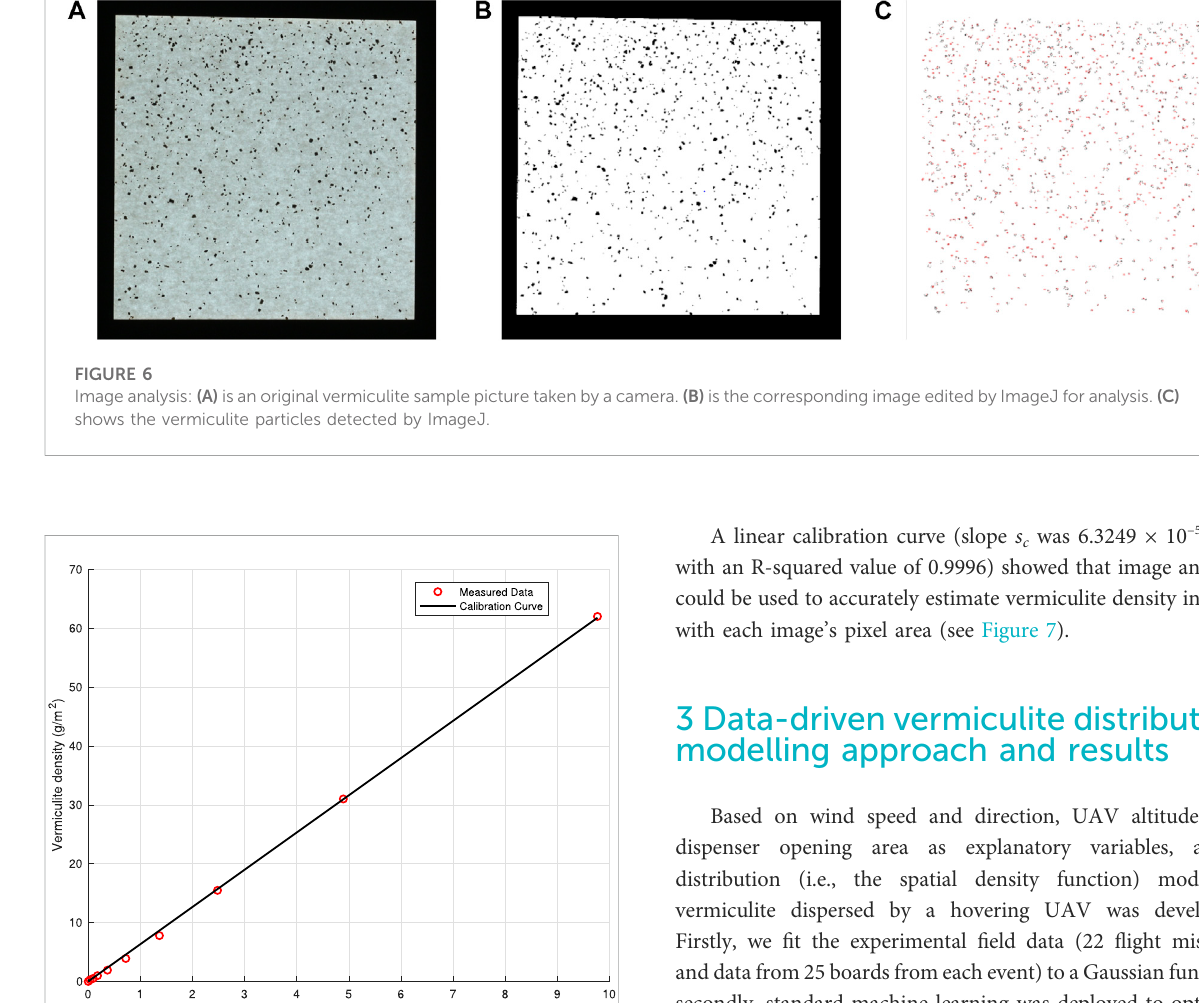
FIGURE 7 Vermiculite density calibration curve: vermiculite density versus pixel area detected by